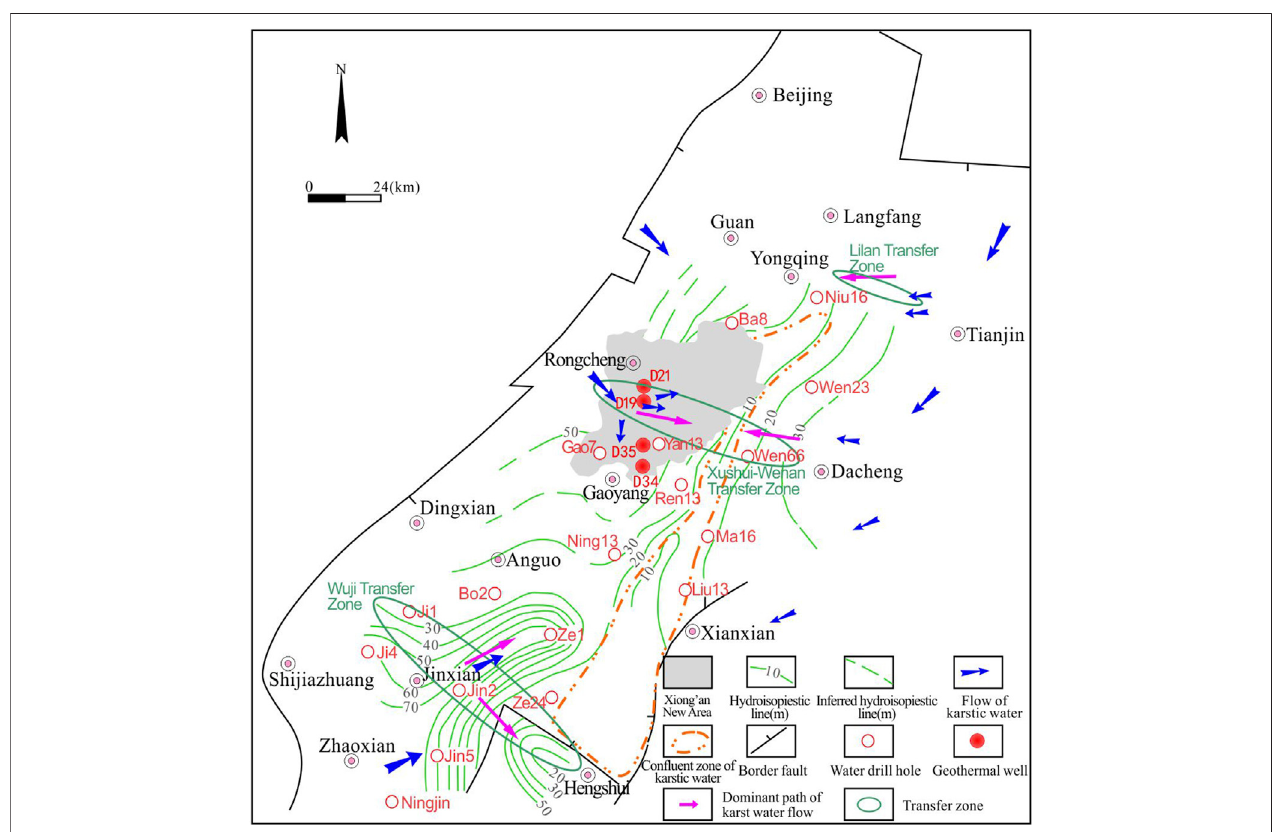
FIGURE 6 | The fl ow path identi fi cation diagram of karst geothermal water in Xiong ’ an New Area and its surroundings.